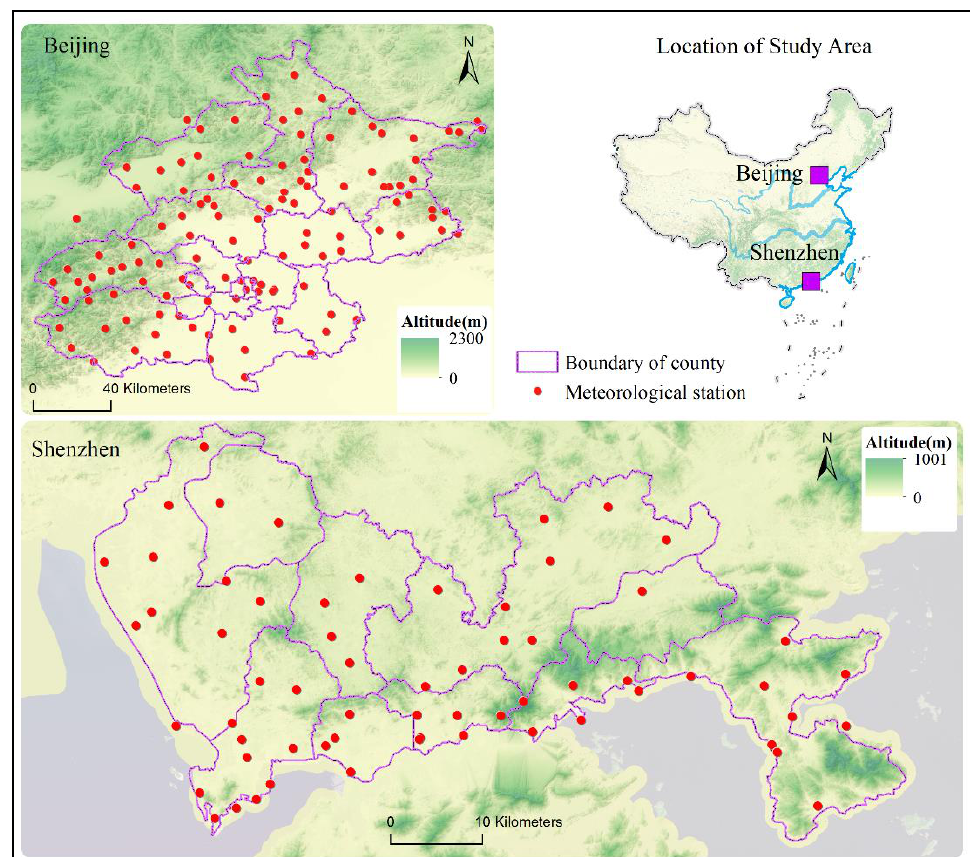
Figure 1. Study area and locations of stations whose data were used in this study.